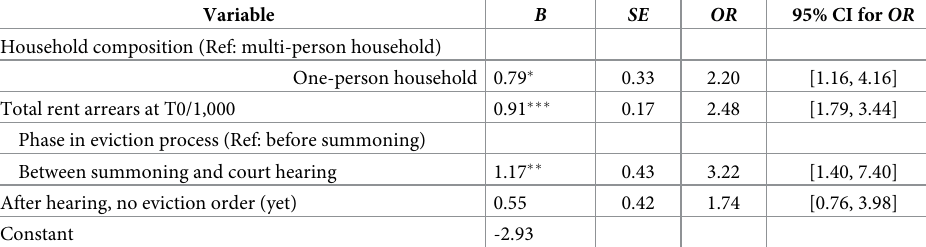
Table 3. Final multiple logistic regression model predicting receiving an eviction order (N = 304). Variable B SE OR Household composition (Ref: multi-person